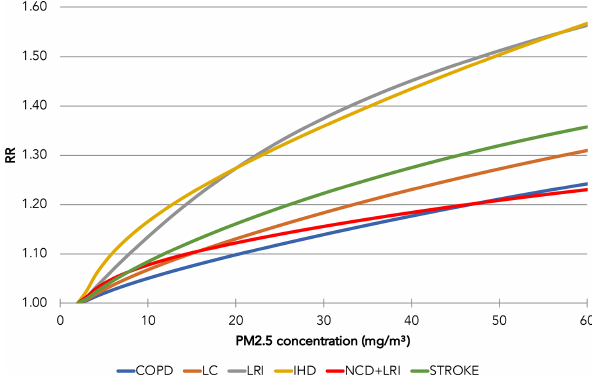
Figure 10. Shapes of the risk ratio functions for the target endpoints as functions of the PM 2 . 5 concentration (µgm − 3